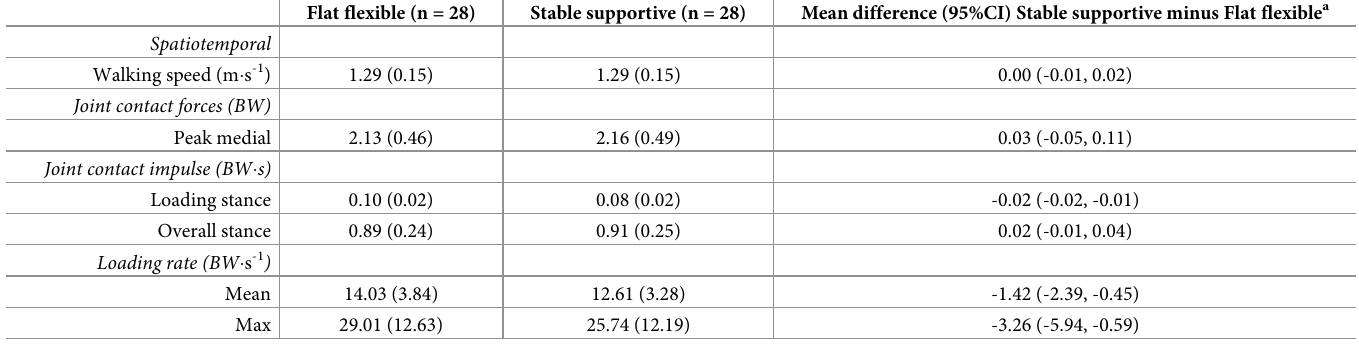
Table 2. Mean change (SD) in spatiotemporal and discrete joint contact force variables for flat flexible and stable supportive shoes, with accompanying mean differ- ences (95% confidence intervals (CI)).